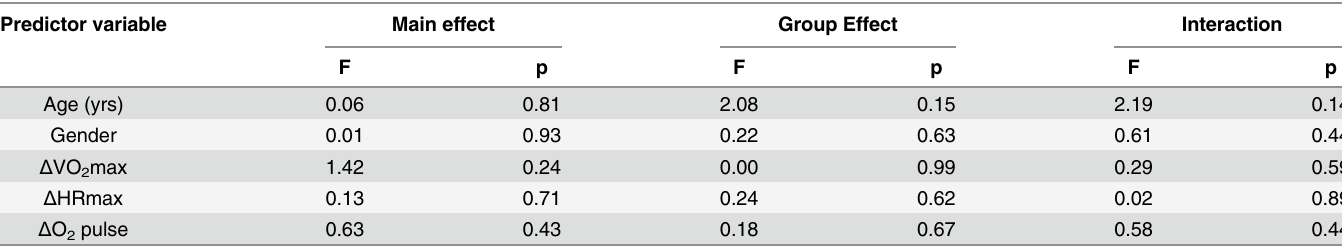
Table 4. Predictors of response in the total